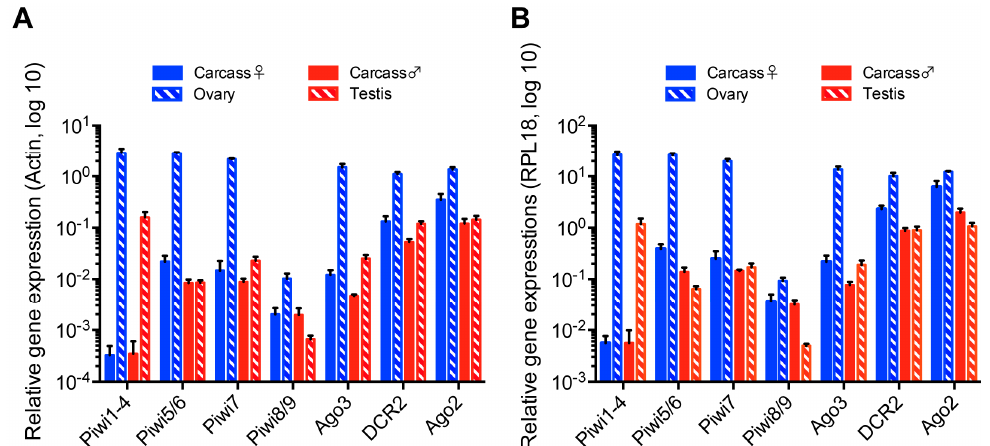
Figure 6. Relative gene expression of siRNA and piRNA pathway components in reproductive tissues and carcasses of Ae. albopictus females and males co-infected with AEFV, MERV, and SHTV. Relative gene expression of the PIWI genes Piwi1-9 and Ago3, together with DCR2 and Ago2, key components of the siRNA pathway, was examined by RT-qPCR. Relative gene expression was calculated by normalization with actin ( A ) or RPL18 RNA ( B ). Multiple unpaired t-test with Holm-Sidak correction was applied to calculate the statistical significance. The P values are summarized in Table S2 and S3.